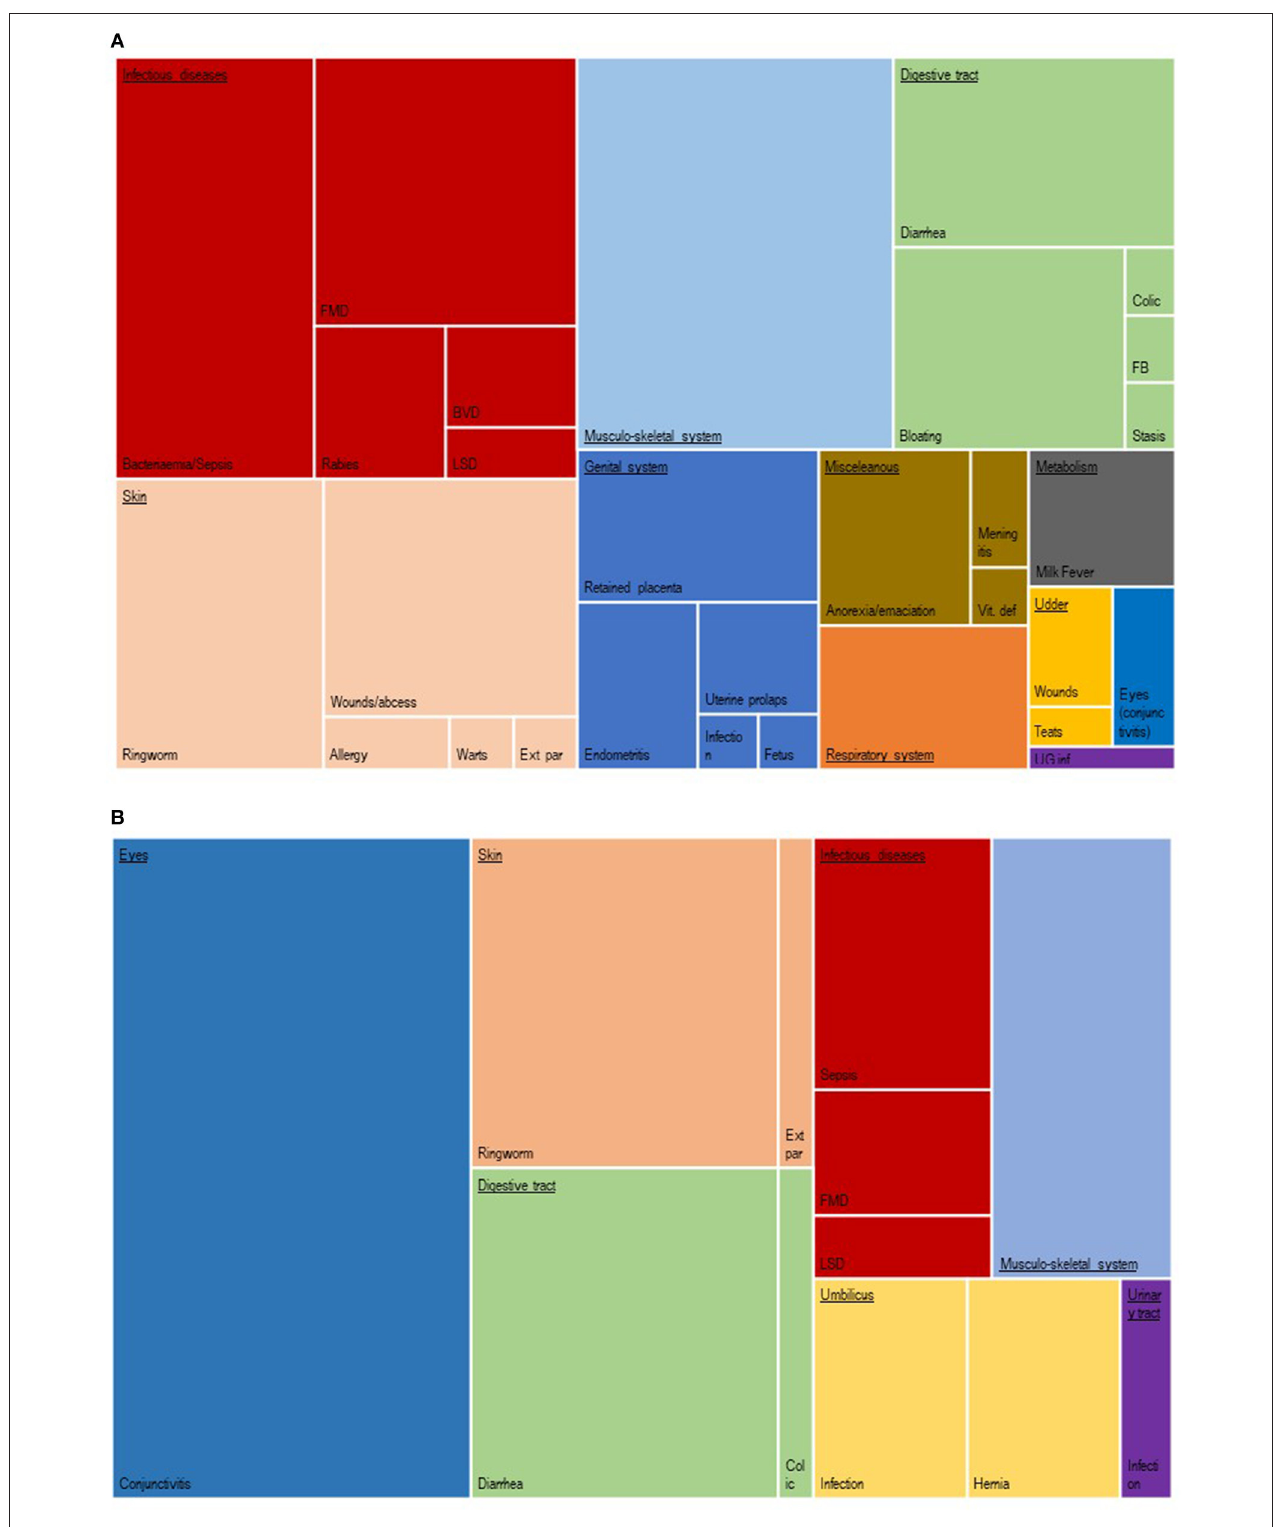
FIGURE 2 | Detailed health problems as recorded in 288 animals ( A in 225 replacement/breeder animals; B in 63 young stock).